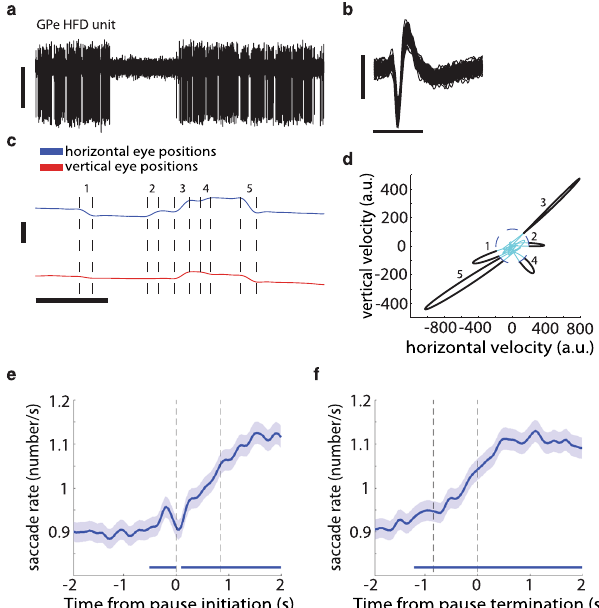
Fig. 2 GPe pauses are positively correlated with the rate of saccadic eye movements. a An example of an extracellular recording in the vicinity of a HFD neuron in the GPe. Vertical scale bar, 100 µ V. Data are shown after 300 – 6000 Hz digital bandpass fi ltering. b 100 randomly chosen, superimposed spike waveforms of the cell shown in a . Horizontal scale bar, 1 ms; vertical scale bar, 100 µ V. c An example of horizontal and vertical eye positions, which were recorded simultaneously with the neuron in a . Horizontal scale bar (for both a , c ), 1 s; vertical scale bar, 200 a.u.; values increase from the lower to the upper part of the bar. Data are shown after digital low-pass fi ltering with a cutoff frequency of 4 Hz. The vertical dashed lines indicate the start and end of saccades. d A plot of the eye positions from c in a 2D velocity space. The threshold for saccade detection is indicated by the blue dashed ellipse. The saccades (in black) are seen as outliers in the velocity space. The numbers beside the saccades correspond to the numbers in c . Abscissa, horizontal velocity in a.u.; ordinate, vertical velocity in a.u. e Average saccade rate around pauses ( n = 33,798 pauses). Abscissa, time ( − 2 to 2 s); ordinate, saccade rate in Hz. The vertical dashed lines at t = 0 and t = ~0.85s indicate the time of pause initiation and mean pause termination, respectively. The horizontal lines indicate activity greater than the mean plus three standard deviations of the saccade rate on the interval from − 2 to − 1.5 s. Saccade rate was computed using 50-ms bins and smoothed with a Gaussian window with a s.d. of 1 ms. Shaded regions represent s.e.m. f Same as e , but the vertical dashed lines at t = 0 and t = ~ − 0.85 s indicate the time of pause termination and mean pause initiation,